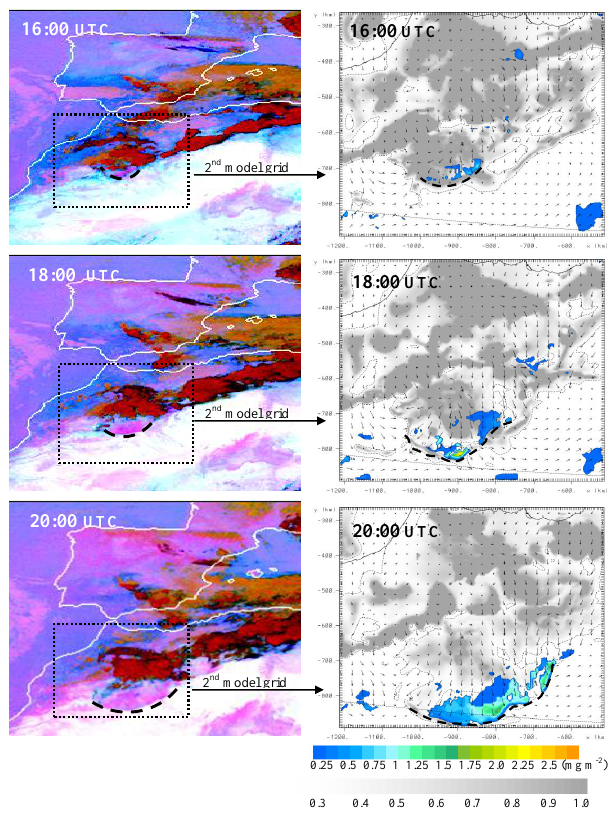
Fig. 3. Left column: MSG/SEVIRI dust indicator satellite images over North West Africa. Dark red colors indicate clouds and pur- ple colors indicate desert dust. Right column: corresponding model cloud fraction (grayscale) and dust production (color palette in mgm − 2 /model timestep). The leading edge of the propagating den- sity current is denoted with black dashed lines.